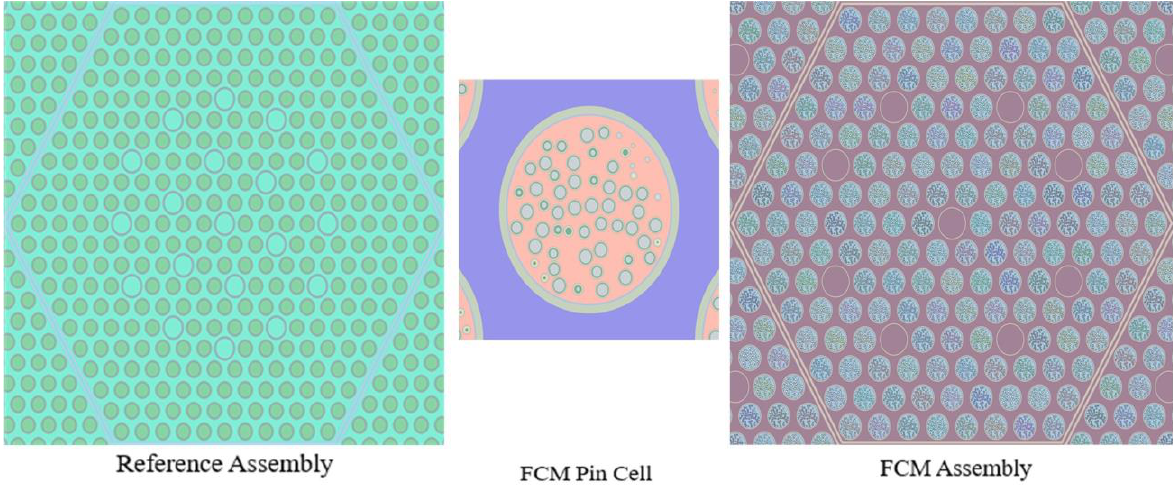
Figure 3. Geometry of Reference and FCM assemblies.